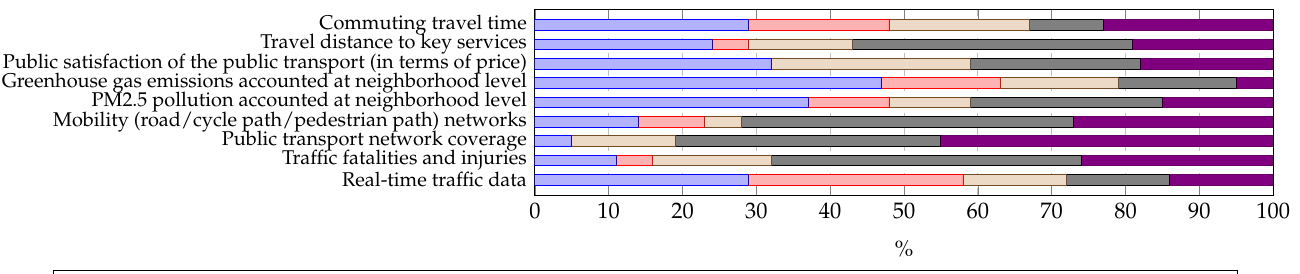
Figure A1. Data availability ( N =